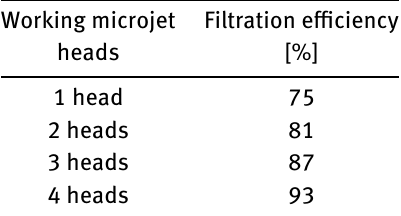
Table 1: Filtration eflciency.